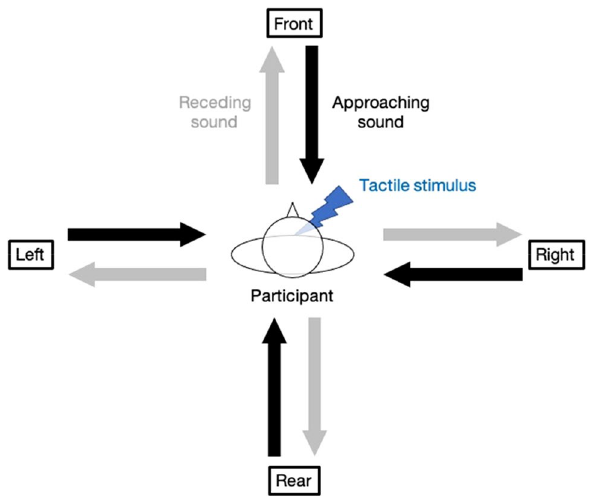
Figure 1. The schematic of the experiment. A virtual audio source was presented. The audio motion was presented toward the participant (approaching sound) or away from the participant (receding sound) in four body-relative directions (front, rear, left, and right). Participants were asked to detect a tactile stimulus presented on the chest as quickly as possible, irrespective of the sound stimulus. Timings of the tactile stimulus and the sound motion were systematically varied.